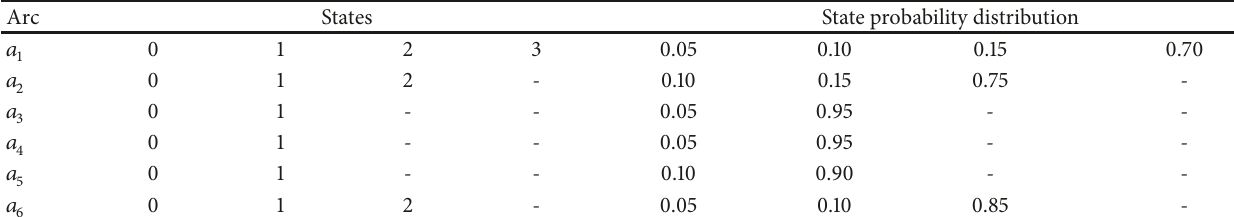
Table 1: The states of arcs in Figure